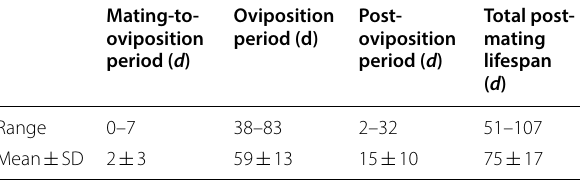
Table 1 Periods of time from mating to the beginning of oviposition, from the beginning to the end of oviposition, and from the end of oviposition to death Mating‑to‑ Oviposition oviposition period period ( d )